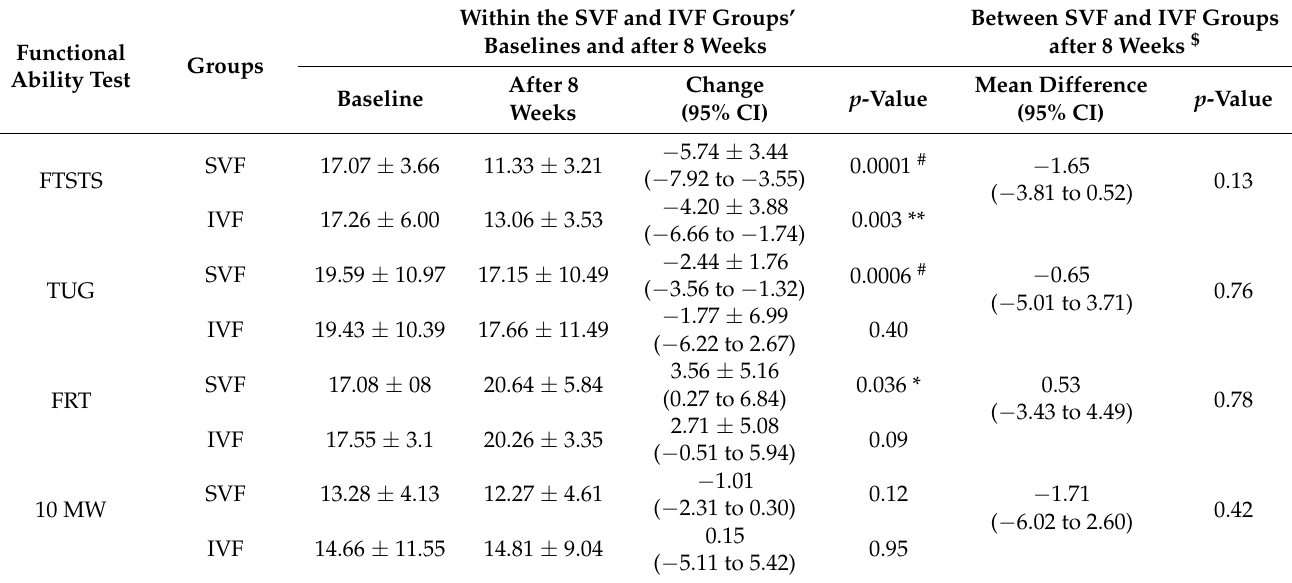
Figure 2. ( A , B ). Comparison of the MAS improvement (% of subject numbers) immediately after ( A ) and after 8 weeks ( B ) of WBV training between the SVF ( n = 12) and IVF ( n = 12) groups. S, stronger spastic leg side; W, weaker spastic leg side. HF, hip flexor; HE, hip extensor; HAD, hip adductor; KF, knee flexor; KE, knee extensor; APF, ankle plantar flexor. *: p < 0.05. The effects of the eight-week WBV training on functional strength, balance, and walking speed are shown in Table 4. Comparing within groups showed the mean difference in the FTSTS, TUG, and FRT significantly improved by − 5.74 ± 3.44 s ( p < 0.001), − 2.44 ± 1.76 s ( p < 0.001) and 3.56 ± 5.16 cm ( p = 0.036) in the SVF group, respectively. Only the FTSTS test significantly improved in the IVF group (mean difference: − 4.20 ± 3.88 cm, p < 0.01), and the 10 MWT revealed no significant difference. Furthermore, no significant difference was found between the groups. Table 4. Comparison of the tests of functional strength, balance, and walking speed within and between the SVF and IVF groups .